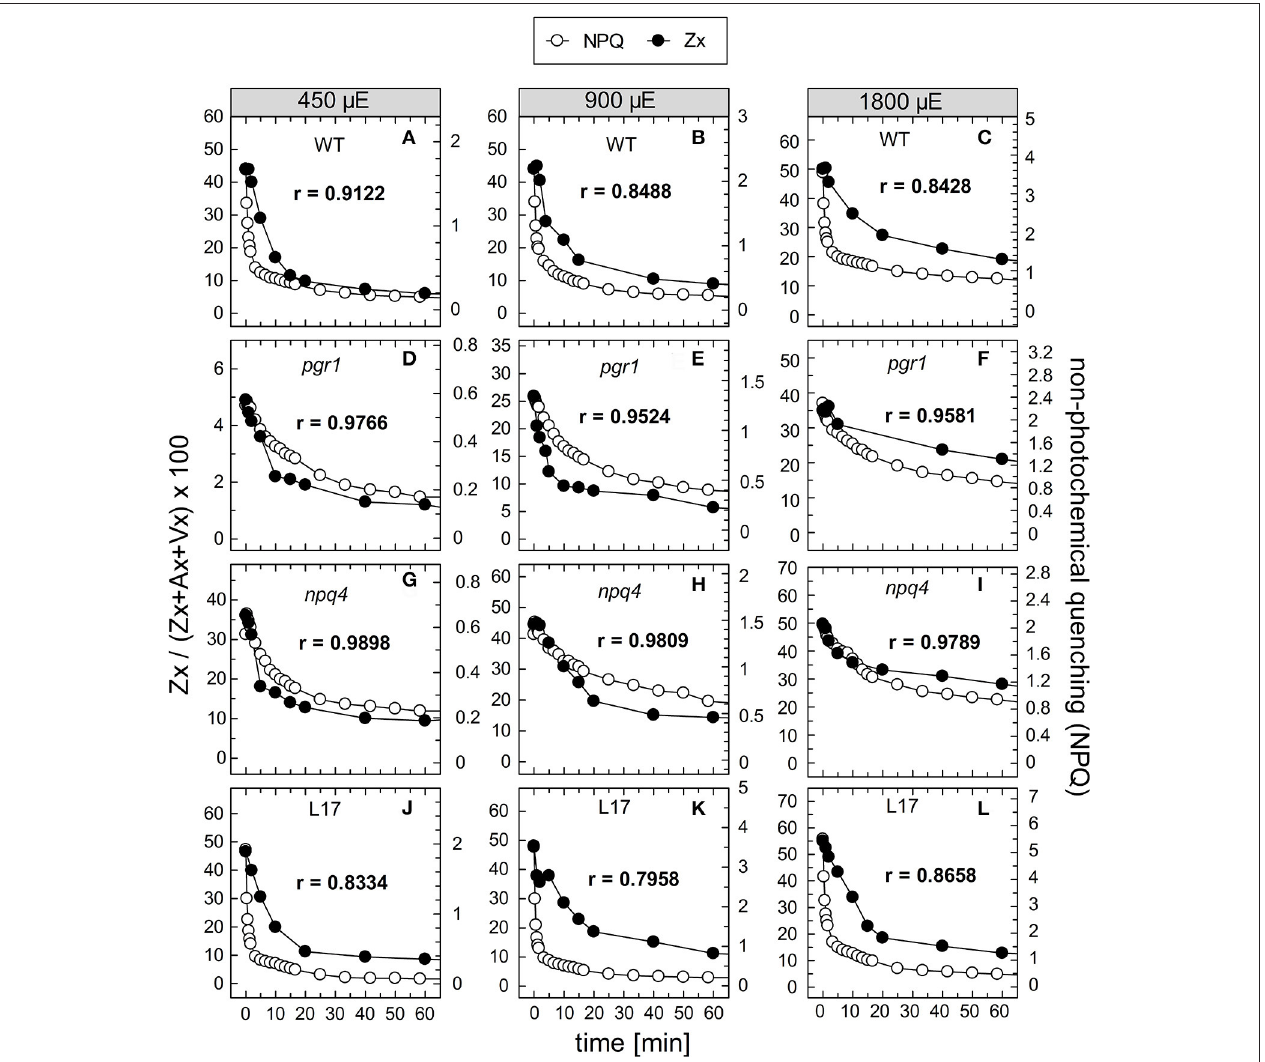
FIGURE 8 | Comparison of NPQ relaxation and Zx epoxidation after 90min of pre-illumination. The time course of NPQ relaxation and Zx epoxidation after 90min of pre-illumination at the three actinic light intensities of 450, 900, and 1800 µ E is compared for the four genotypes with an active xanthophyll cycle: (A–C) WT, (D–F) pgr1 , (G–I) npq4, and (J–L) L17 . The data were taken from Figure 6 (NPQ) and Figure 7 (Zx). The determined Pearson’s correlation coefficient r is indicated in each